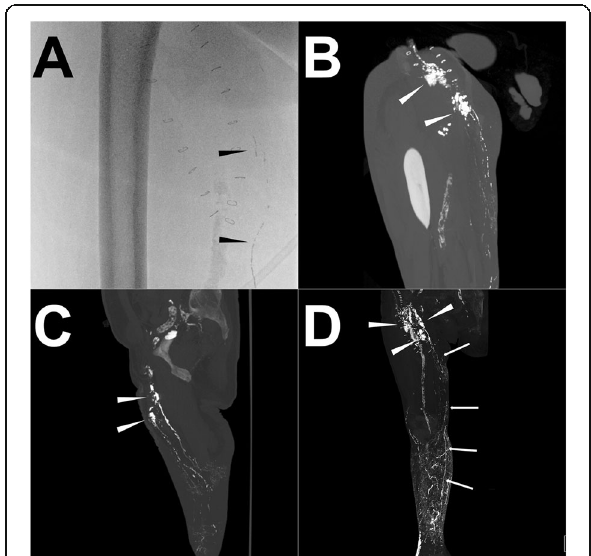
Fig. 1 Illustration of the iodized oil-based LAG and post-LAG CT performance. Note: A patient with occurring persistent postoperative LF in the right groin after endovascular artery repair for an infrarenal abdominal aneurysm through the right femoral artery route. In the iodized oil-based LAG procedure, a total of 15 ml of lipiodol was injected with a velocity of 1 ml/min. However, due to the slow outflow of the lipiodol, 20 min after the accomplishment of the injection, the lipiodol only went up to the middle third of the thigh (black arrowhead) under the fluoroscopy and no obvious extravasation was found ( a ). 4 h later, the post-LAG CT was sequentially performed. The coronal ( b ) and sagittal ( c ) MIP images show definite extravasation of lipiodol (white arrowhead) at the right thigh with at least two points. The 3D-VR image ( d ) clearly visualized the major flowing route of the lymphatic fluid from calf to groin (white arrow) and the LF points (white arrowhead). Besides, abnormal lymphatic collateralization in calf could be observed ( d ). Abbreviations: LF – lymphatic fistula; LAG –